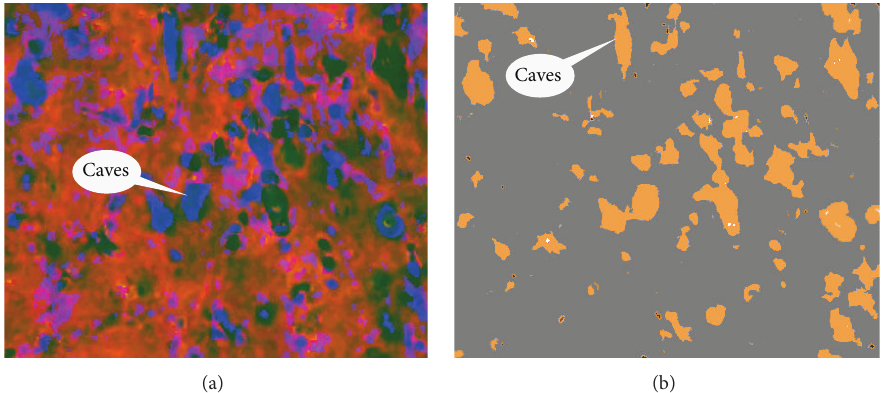
Figure 7: (a) Slice of the color-blended volume; (b) carbonate karst caves analysis based on the